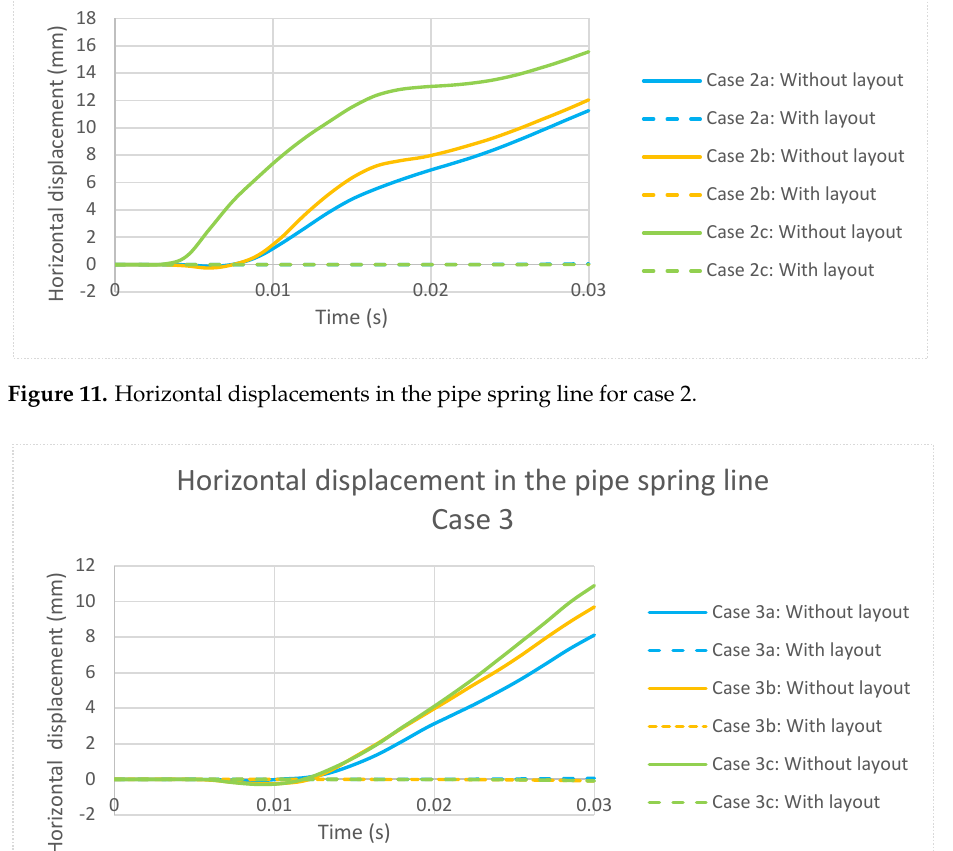
Figure 12. Horizontal displacements in the pipe spring line for case 3.